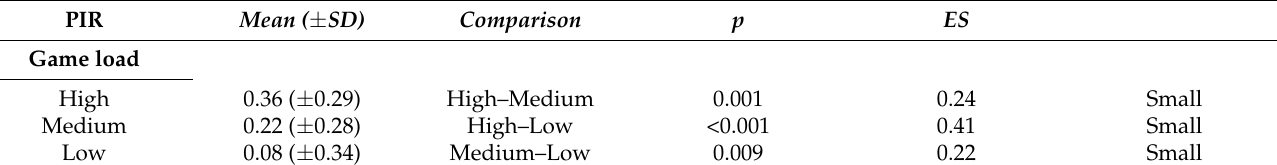
Table 9. Pairwise comparison for